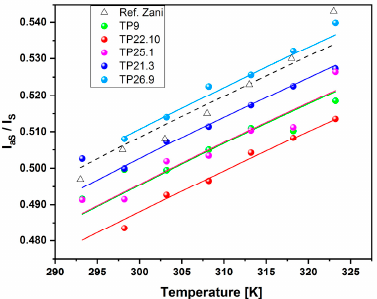
Figure 12. Response curves of the tested materials: TP9 sample (green dots), TP22.10 (red dots), TP25.1 (violet dots), TP21.3 (blue dots) and TP26.9 (sky blue dots). Literature data, open triangles, are also reported for comparison [26]. The error bars are omitted to make the graph easier to see.